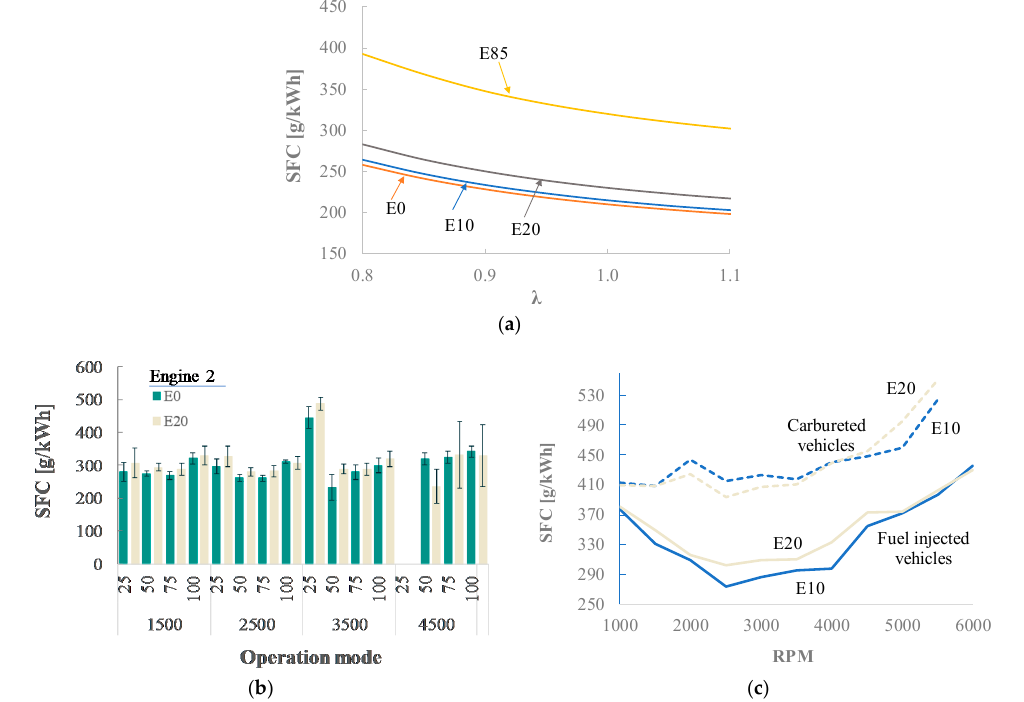
Figure 3. Results of specific fuel consumption (SFC) obtained: ( a ) analytically; ( b ) testing engine 2 under steady-state conditions; and ( c ) carbureted and fuel-injected vehicles under steady-state conditions at full load on the chassis dynamometer after 72,000 km of operation .